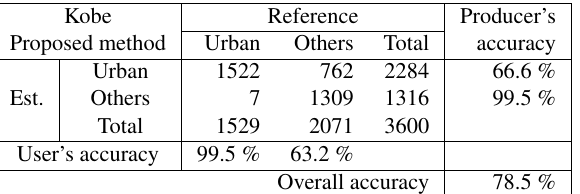
Table 3. Accuracy of extracted urban areas in study area 1